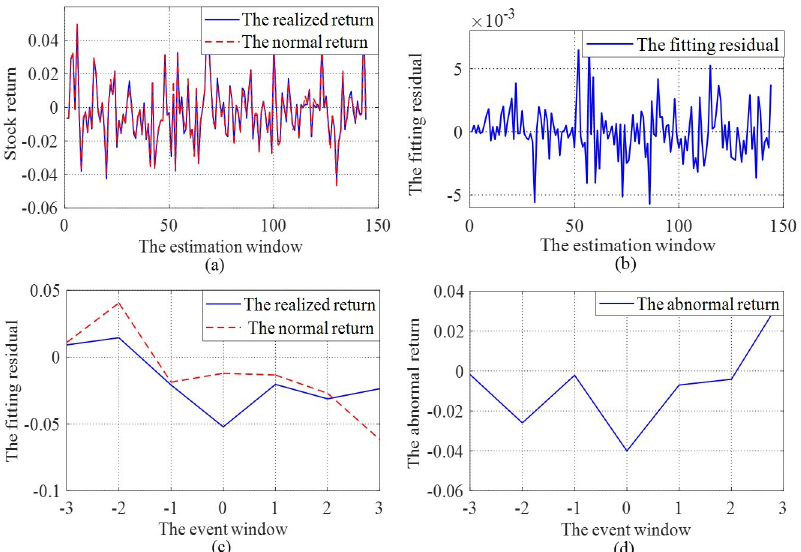
Fig 4. Exercising and estimating results of the ENN model. This figure plots the calculating process of the ENN model for four sectors: (a) The realized return and the normal return estimated by the ENN model in the estimation window of an individual firm; (b) The fitting residual in the estimation window; (c) The realized return and the normal return estimated by the ENN model in the event window; (d) The abnormal returns of an individual firm.